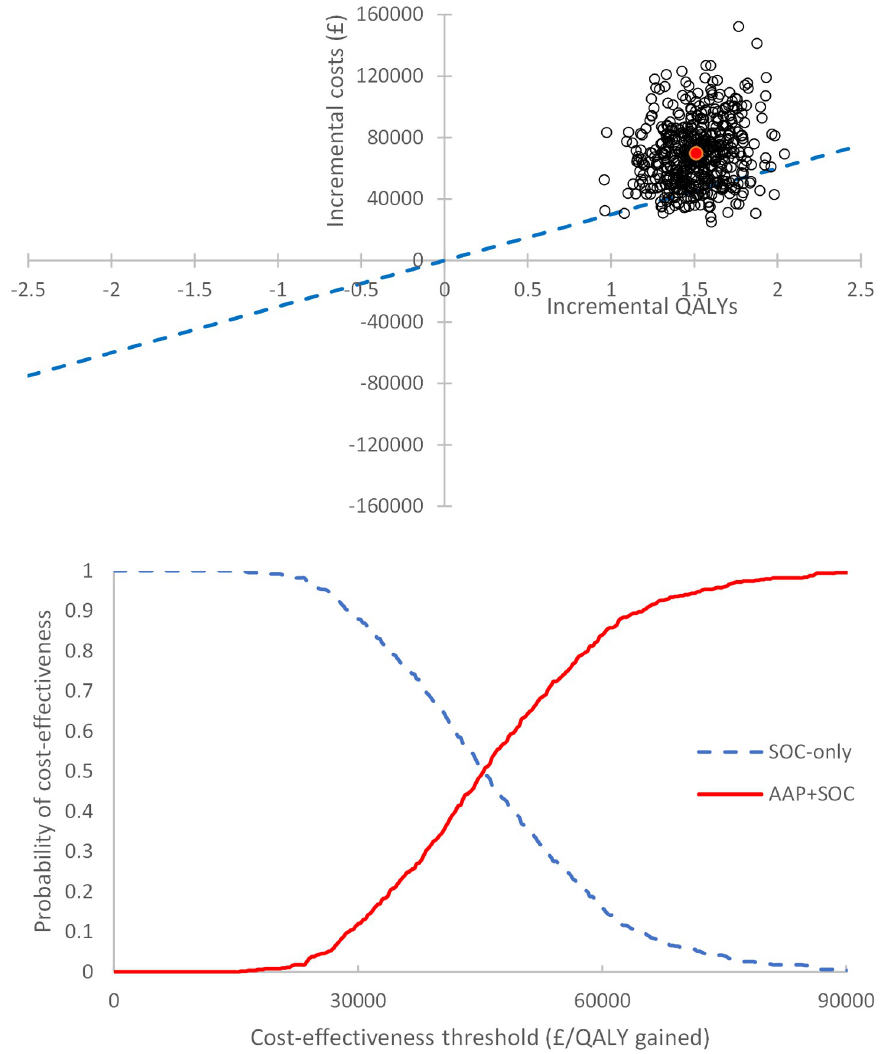
Fig 3. Cost-effectiveness plan and cost-effectiveness acceptability curve for the M1 subgroup. Top: Cost- effectiveness plane (CEP) for M1 subgroup, using base case BNF price for abiraterone. The red point indicates the mean incremental cost plotted against the mean incremental QALYs in this set of probabilistic results and the blue dotted line indicates the £30,000/QALY gained cost-effectiveness threshold. Bottom: Cost-effectiveness acceptability curve (CEAC) for M1 subgroup, using base-case BNF price for